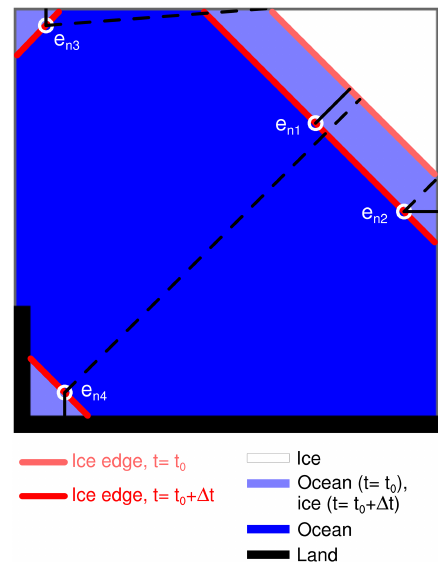
Figure B1. Binary fields with values of 1 (ice) and 0 (no ice/ocean) are displayed by white and blue color shading, respectively. Land is indicated as a black region. Light shades of blue indicate regions with a non-overlapping ice cover, as indicated by the color legend. Open boundary grid cells are depicted as gray lines. Ice edges for t 0 and t 0 + (cid:49)t are drawn as light red and red lines, respectively. Dashed black lines show the edge displacements as defined in Sect. 2.1 for a selection of labeled ice edge grid cells from t 0 + (cid:49)t , marked by white circles. Full black lines display the displacements (cid:101) d that result from the modifications described in Appendix B; see Eq. (B8). For the set of grid cells that are highlighted here, only e n 1 is unaffected by the modified